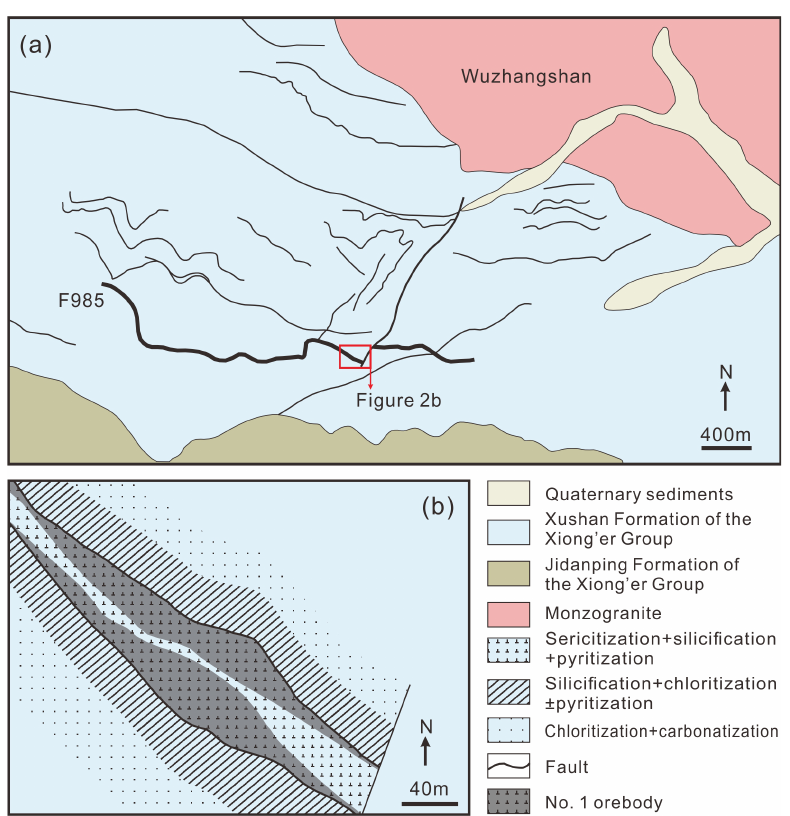
Figure 2. Simplified geological maps of ( a ) the Huanxiangwa district and ( b ) the No. 1 orebody of the Huanxiangwa deposit [38].